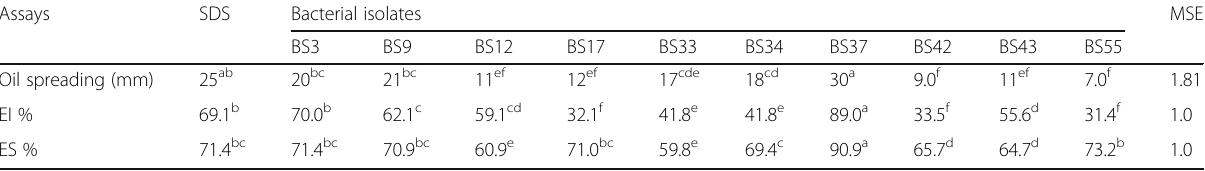
Table 1 Screening of the isolated bacteria for biosurfactant production Assays SDS Bacterial isolates